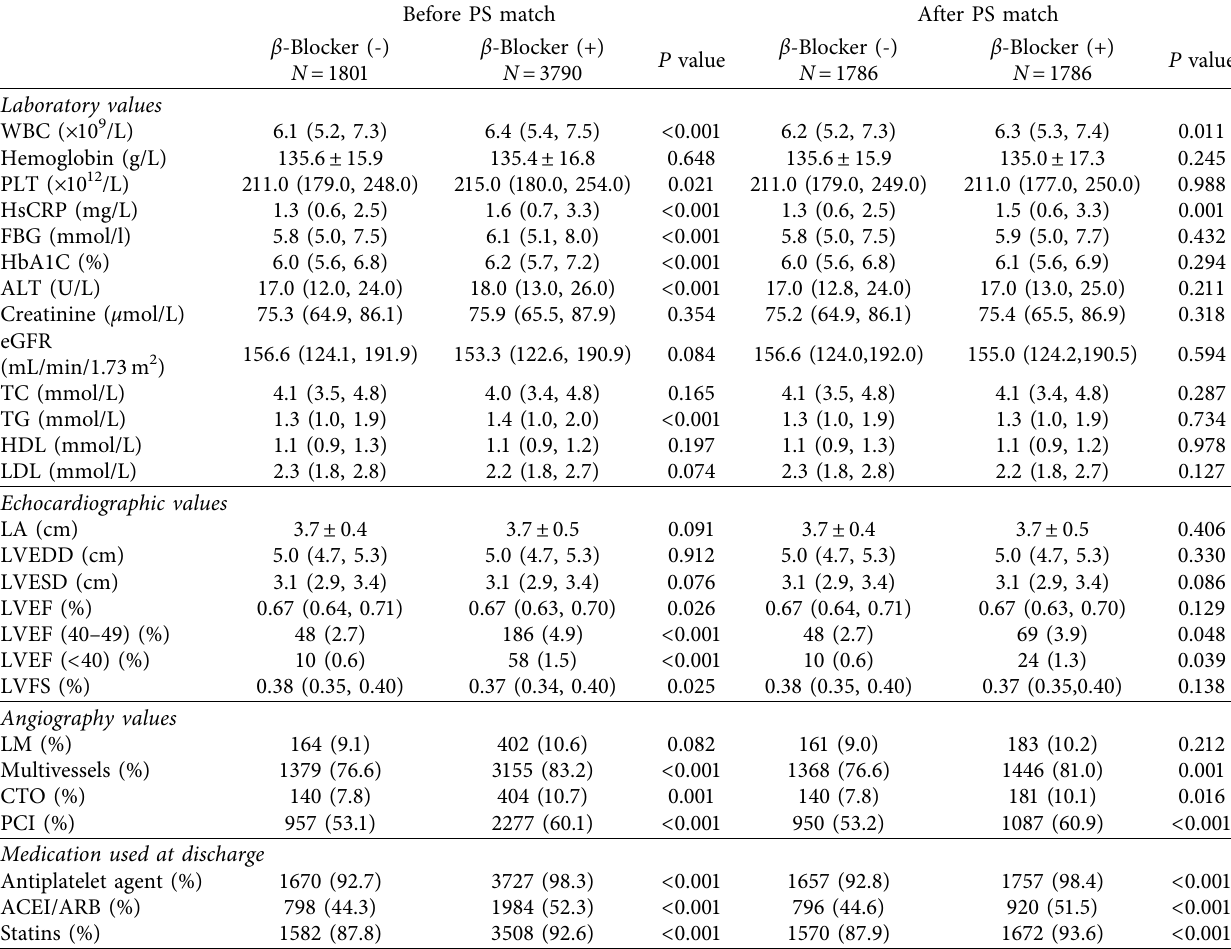
Table 2: Laboratory test results and echocardiographic and angiographic